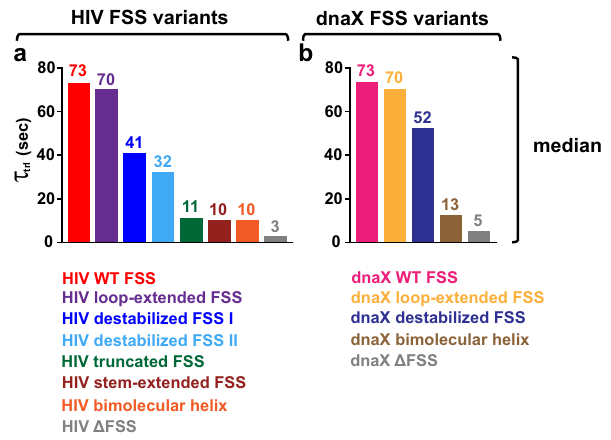
Fig. 6 The stem length and the presence of the loop are more important for the FSS-induced inhibition of translocation than FSS local and overall thermodynamic stabilities. The S6-cy5/L9-cy3 ribosomes were programmed with mRNA containing either an HIV ( a ) or dnaX ( b ) FSS variant as indicated (Fig. 1). Bar graphs show median values of τ trl . Respective mean values of τ trl together with standard error of the mean (SEM) and standard deviations (SD) are shown in Supplementary Fig. 5. For all FSS variants but the HIV stem-extended FSS, τ trl represents the dwell time between injection of EF-G (cid:129) GTP and ribosome translocation in smFRET experiments. For the HIV stem-extended FSS, τ trl corresponds to the dwell time between tRNA binding and translocation (Fig. 7). Source data are provided as a Source Data fi